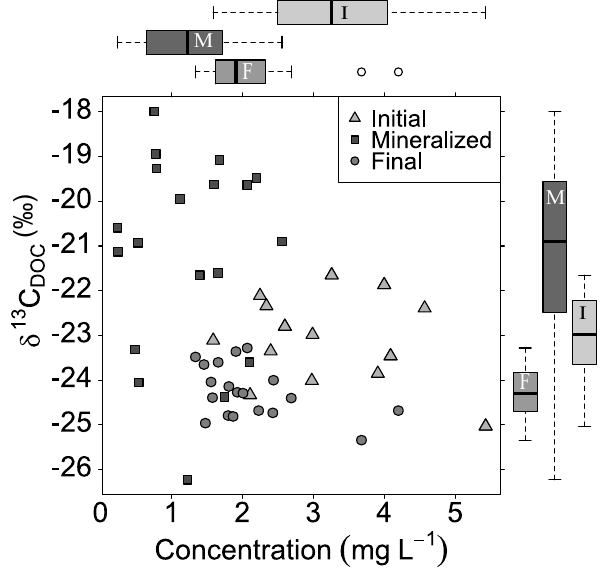
Figure 6. Calculated values of the concentration and isotopic sig- nature of the mineralized DOC pool, for incubation series that ex- perienced a sufficiently high loss of DOC. The horizontal box plots indicate the distribution of the concentration while the vertical ones indicate the distribution of the stable isotope signature for the initial (I), mineralized (M) and final (F) DOC. Incubation series with and without POC are represented, as long as the relative error on the concentration was less than